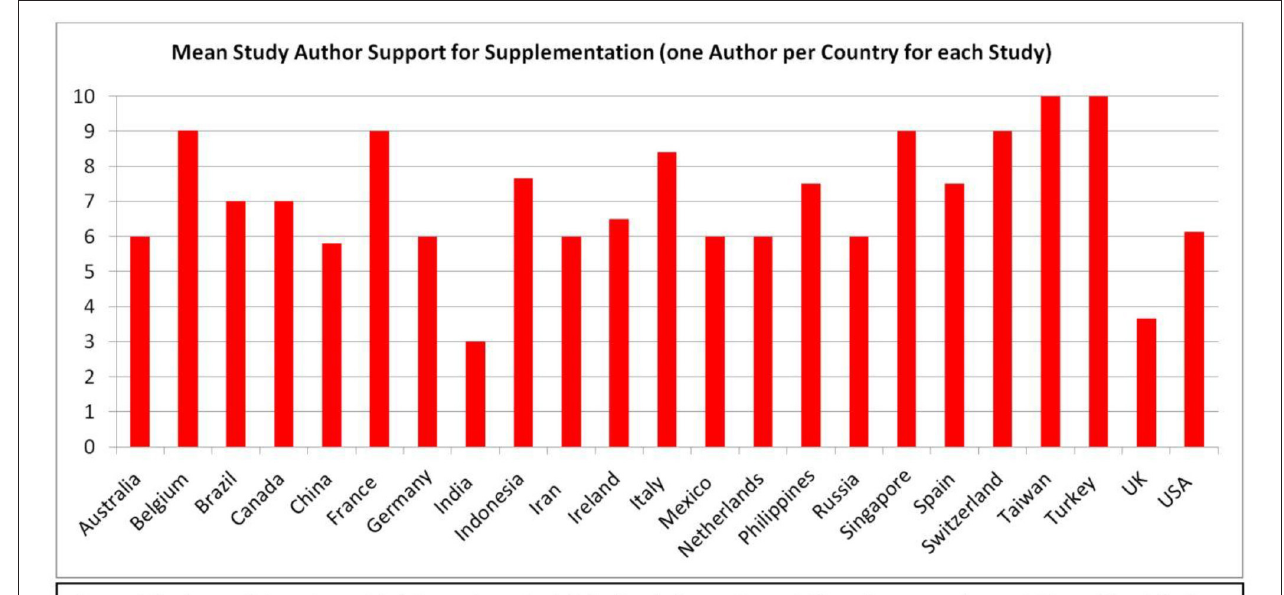
FIGURE 2 | Study authors’ supplementation support by